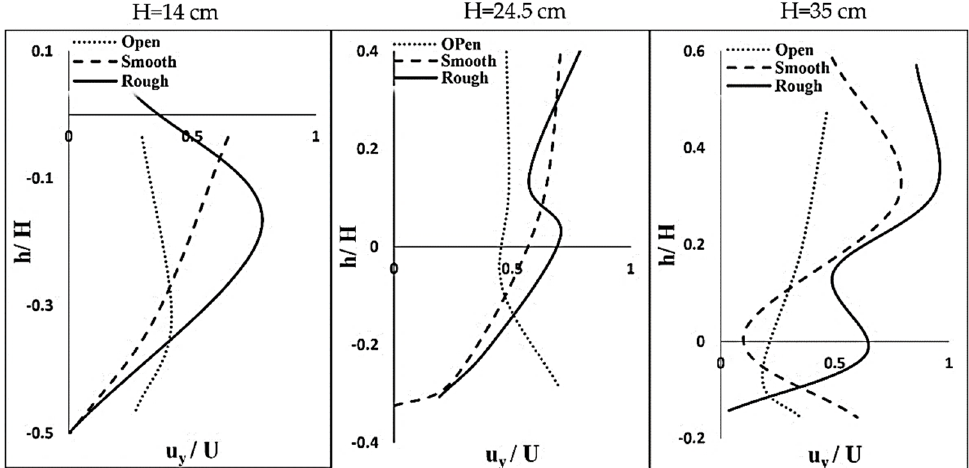
Figure 10. Lateral velocity profile (u y ) inside and outside the scour holes under different surface cover conditions for the dike orientation angle of 90° for different water depths. ADV measurements subject to +/- 0.25 cm/s error.